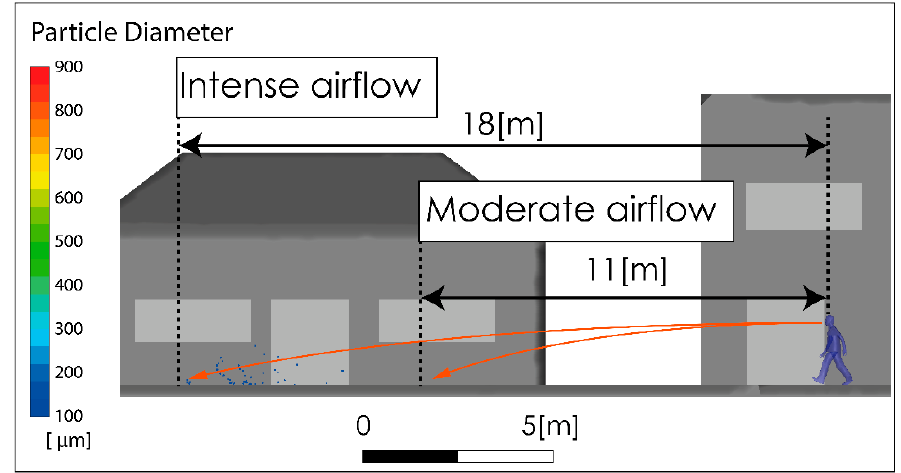
Figure 10. Visualization of the maximum range of small drops produced by a sneeze, with moderate and high intensity airflow.